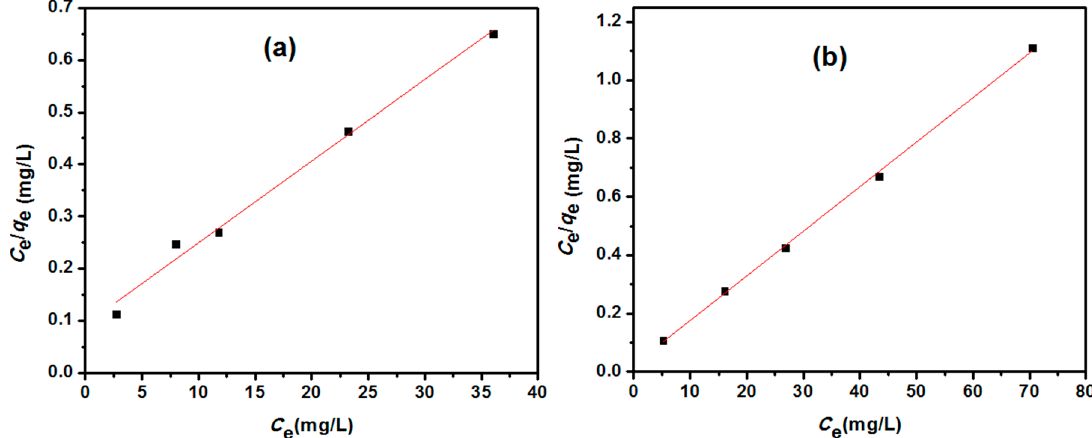
Figure 11. Langmuir sorption isotherm of ( a ) U(VI) and ( b ) Th(IV) sorption onto HQ-bentonite. Conditions: 0.1 g HQ-bentonite; 50 mL solution; U(VI) (pH 4), Th(IV) (pH 3); shaking time U(VI) (15 min.), Th(IV) (8 min.); temperature 303 K. Table 2. Isotherms parameters and values of linear correlation factors ( R 2 ) for sorption of U(VI) and Th(IV) ions onto HQ-bentonite.